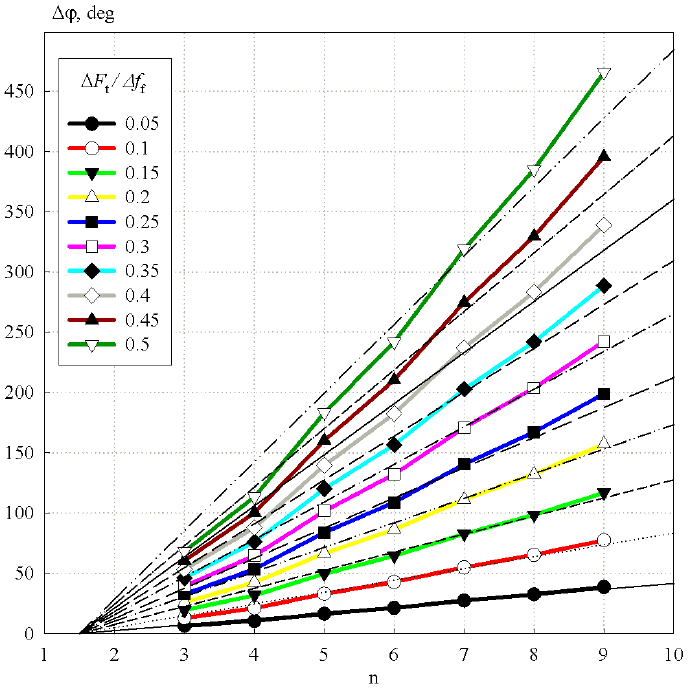
Figure 3. Phase shift versus the number of